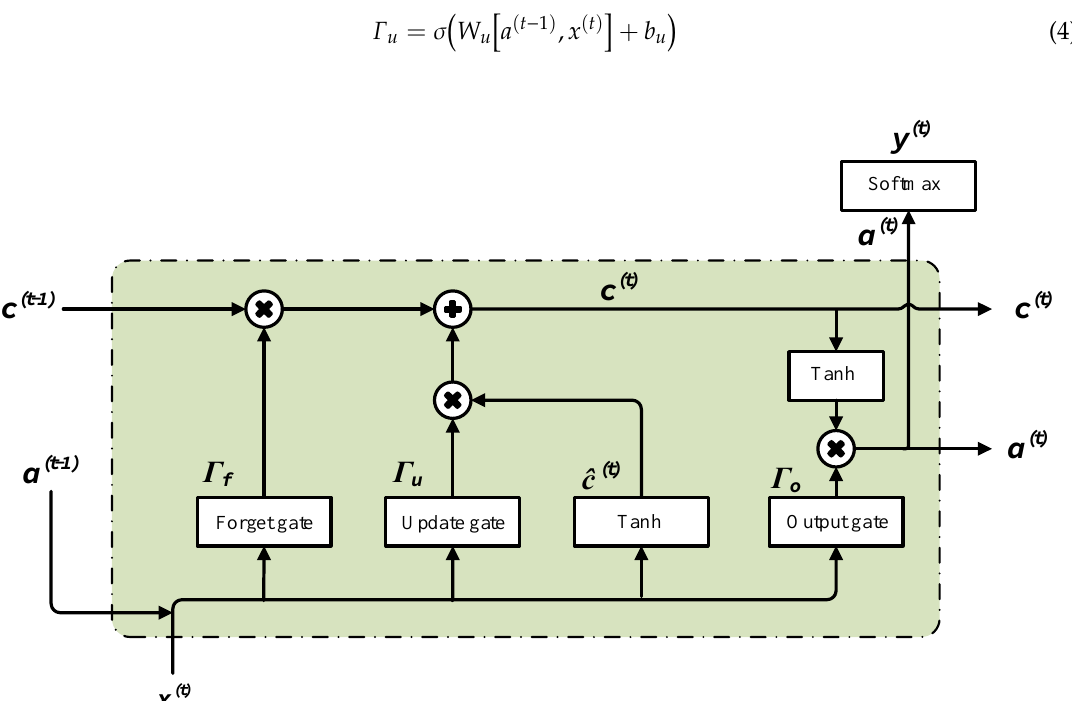
Figure 2. A single recurrent neural networks (RNN) unit showing LSTM architecture.